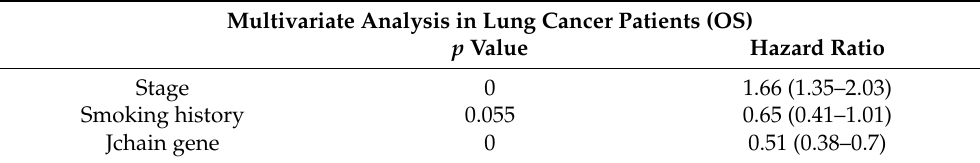
Table 3. Multivariate analysis considering overall survival in lung cancer patients. Multivariate analysis of J chain gene expression and smoking history and stage on overall survival in lung cancer (n = 583) patients.